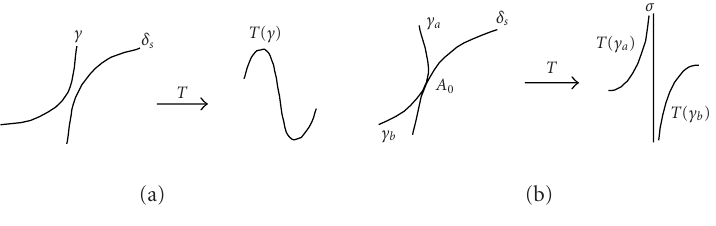
Figure 3.1. Image of a smooth curve γ when there is a contact between this last and the set of non- definition δ s